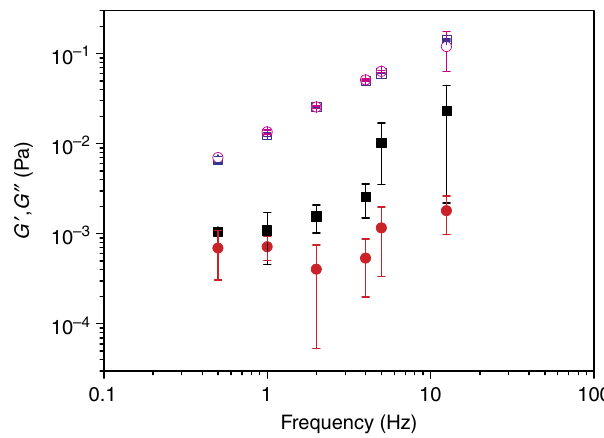
Fig. 4 Viscoelastic properties of bacterial local environment. Storage modulus ( G ´ , fi lled symbols) and loss modulus ( G ˝ , open symbols). Storage and loss moduli of SYM growth medium are represented with circles. The extracellular matrix storage and loss moduli of dilute B. subtilis wt bacterial suspensions are represented with squares. The average values and standard deviations are given ( n =